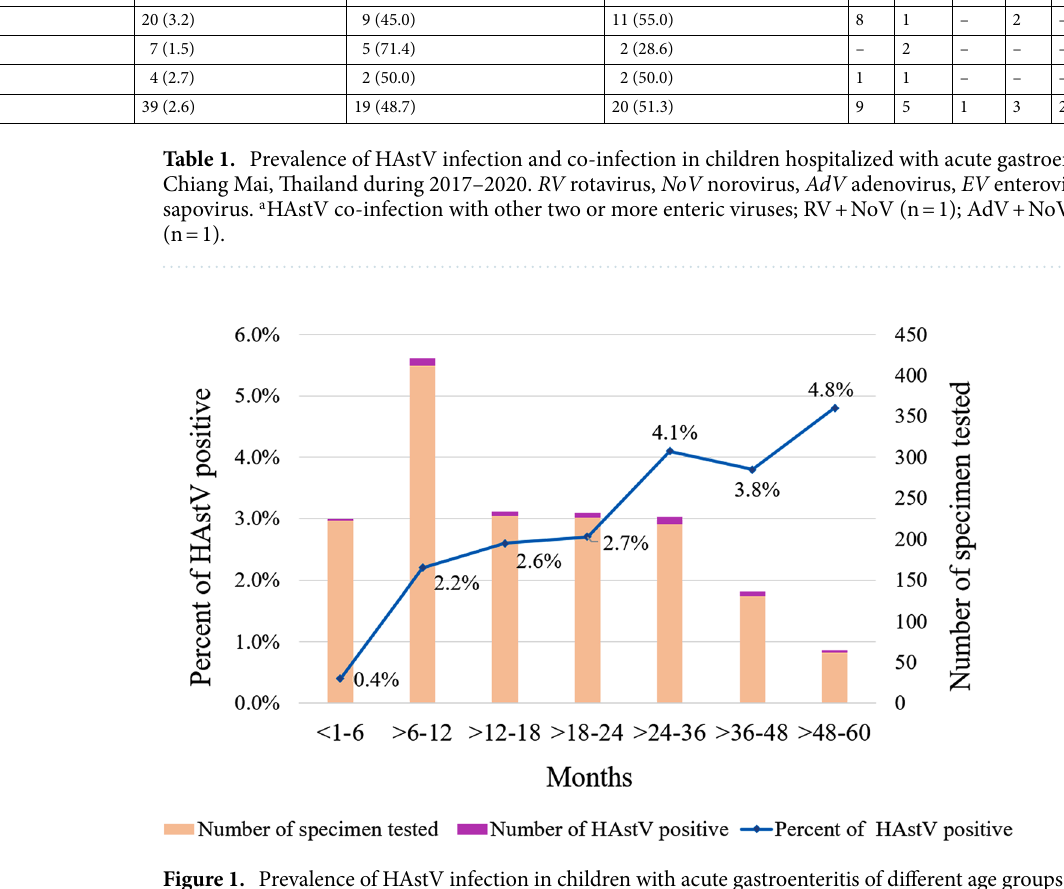
Figure 1. Prevalence of HAstV infection in children with acute gastroenteritis of different age